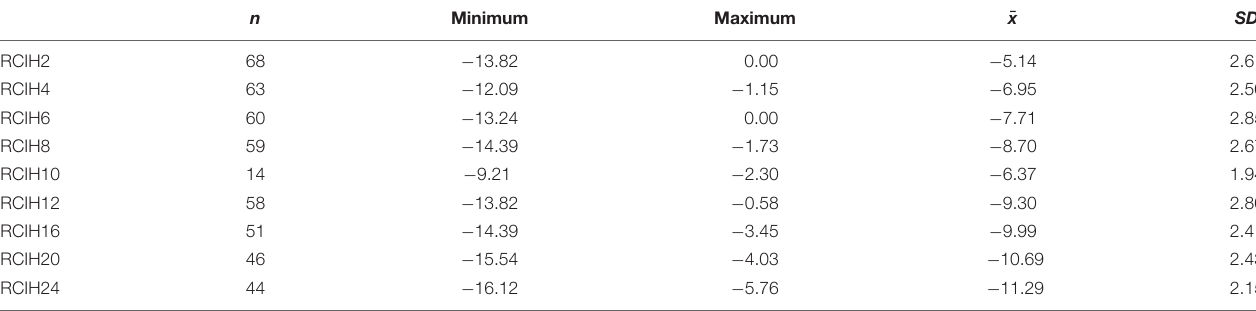
TABLE 2 | Descriptive statistics of the reliable clinical index for every week of treatment.